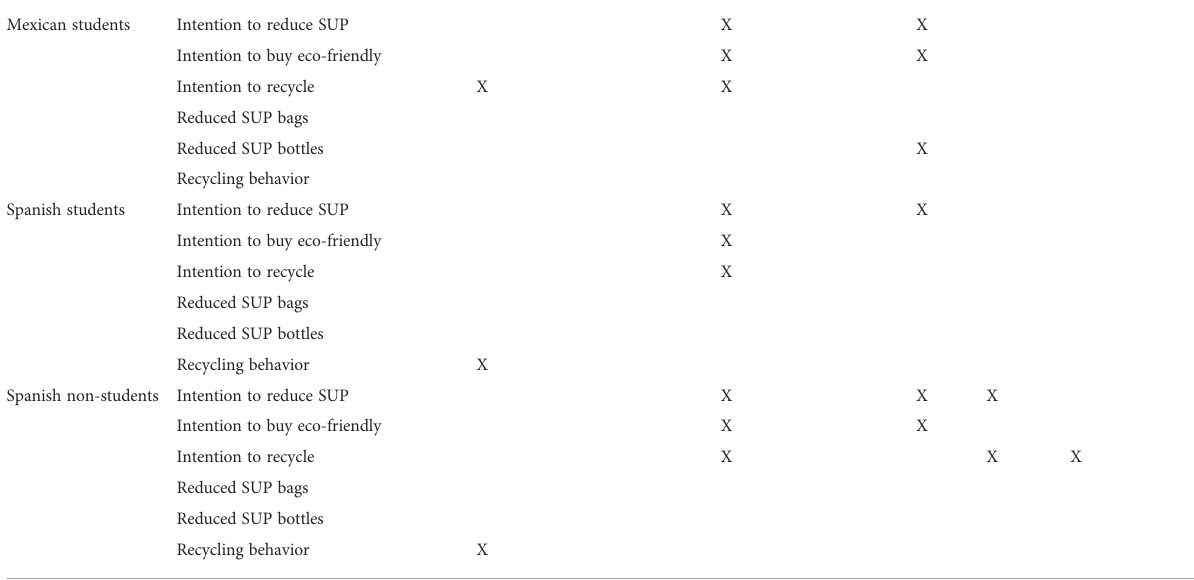
Signi fi cant predictors are marked with X. Shaded squares mean not tested for lack of variation of these parameters in student samples. SUP, single-use